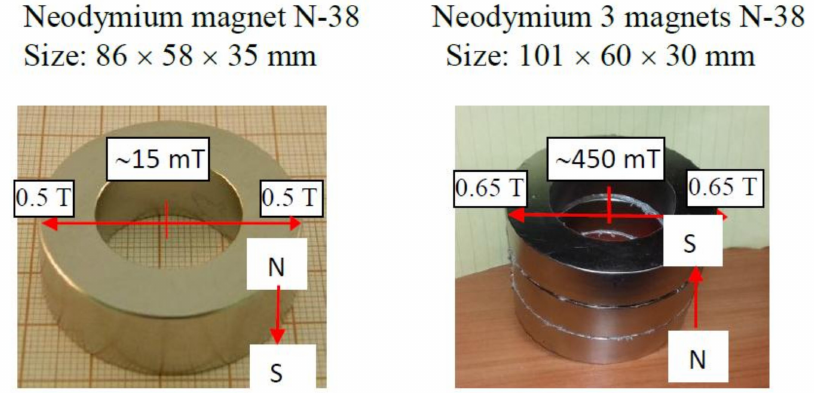
Figure 1. The magnets and the magnetic field strengths.